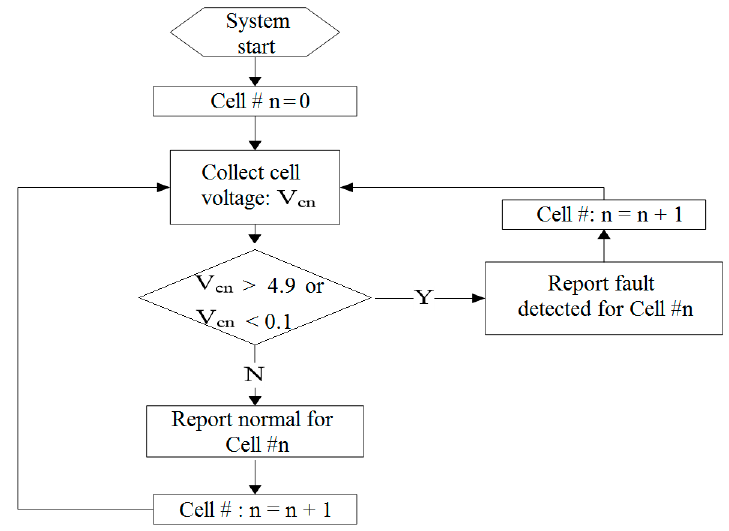
Figure 7. Flowchart of open-wire fault diagnosis strategy.